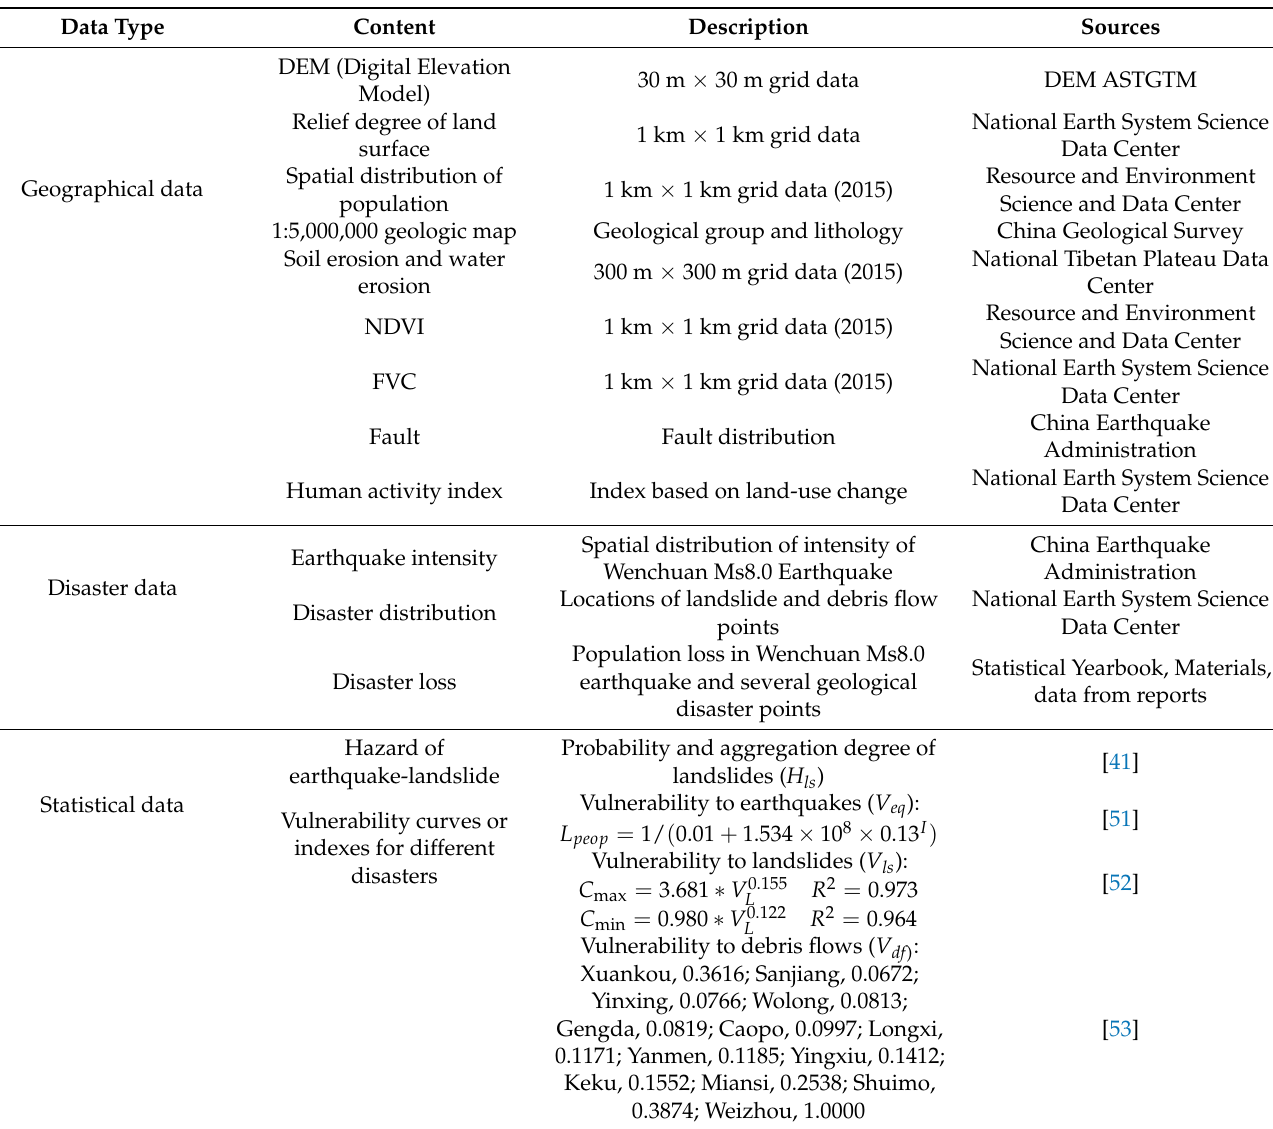
Table 1. Sources of the data used for the risk assessment of the earthquake-landslide-debris flow disaster